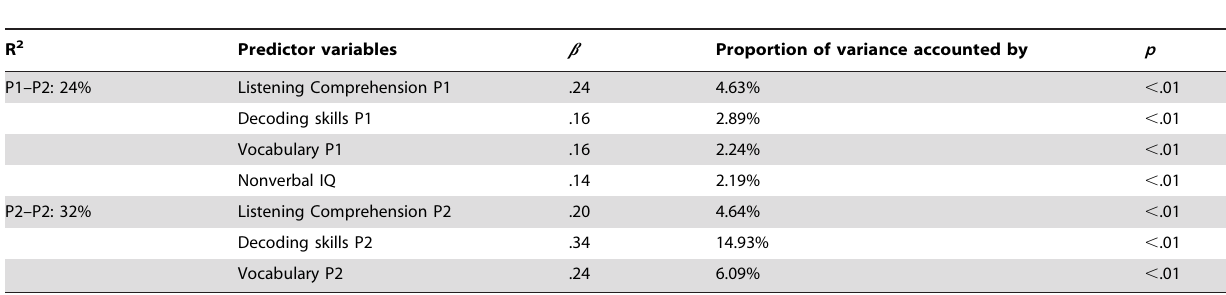
Table 6. Standard multiple regression analyses with the reading comprehension of a story as dependent variable and variables of interest in P1 and P2 as predictors (for decoding skills: fluency for pseudoword reading).